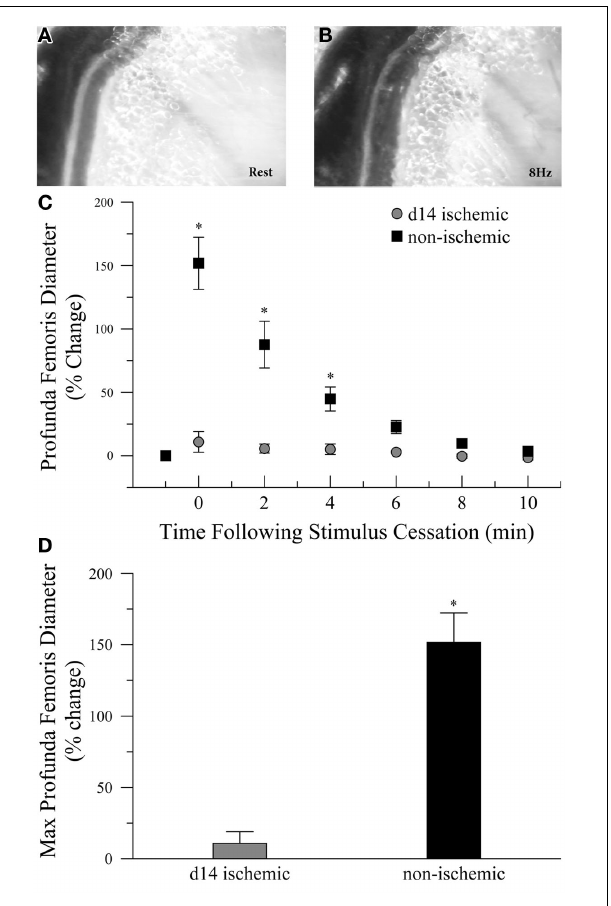
FIGURE 1 | Intravital microscopy imaging field and functional vasodilation responses in the profunda femoris arteries, in vivo . (A) Representative photomicrographs of the distal profunda femoris artery–vein pair imaging site for functional vasodilation and vascular reactivity studies at rest and (B) immediately following the cessation of 8Hz muscle contraction. (C) Resting diameter and 10min following 90s of 8Hz muscle contraction in day-14 ischemic (gray circles) and contralateral control (black boxes) profunda femoris arteries. (D) Maximal functional vasodilation in day-14 ischemic (gray) and contralateral control (black) profunda femoris arteries following 90s of 8Hz muscle contraction. Data points are on a relative scale, with resting diameter represented by 0%. ∗ p ≤ 0.05 versus day-14